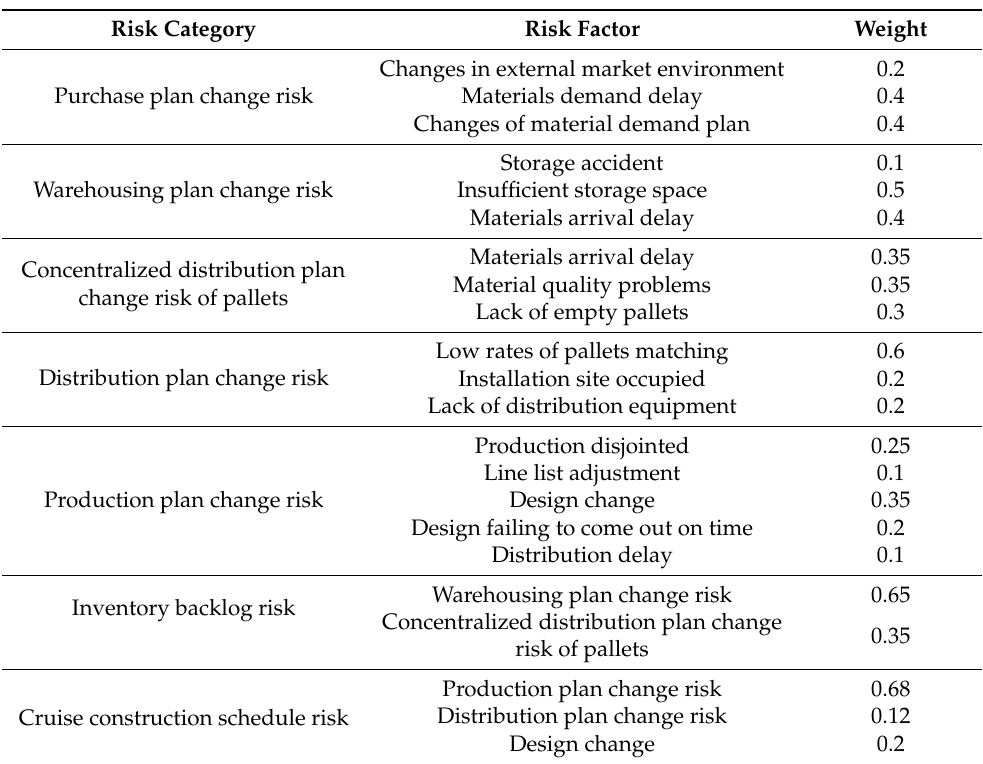
Table 1. Weight of risk factor.